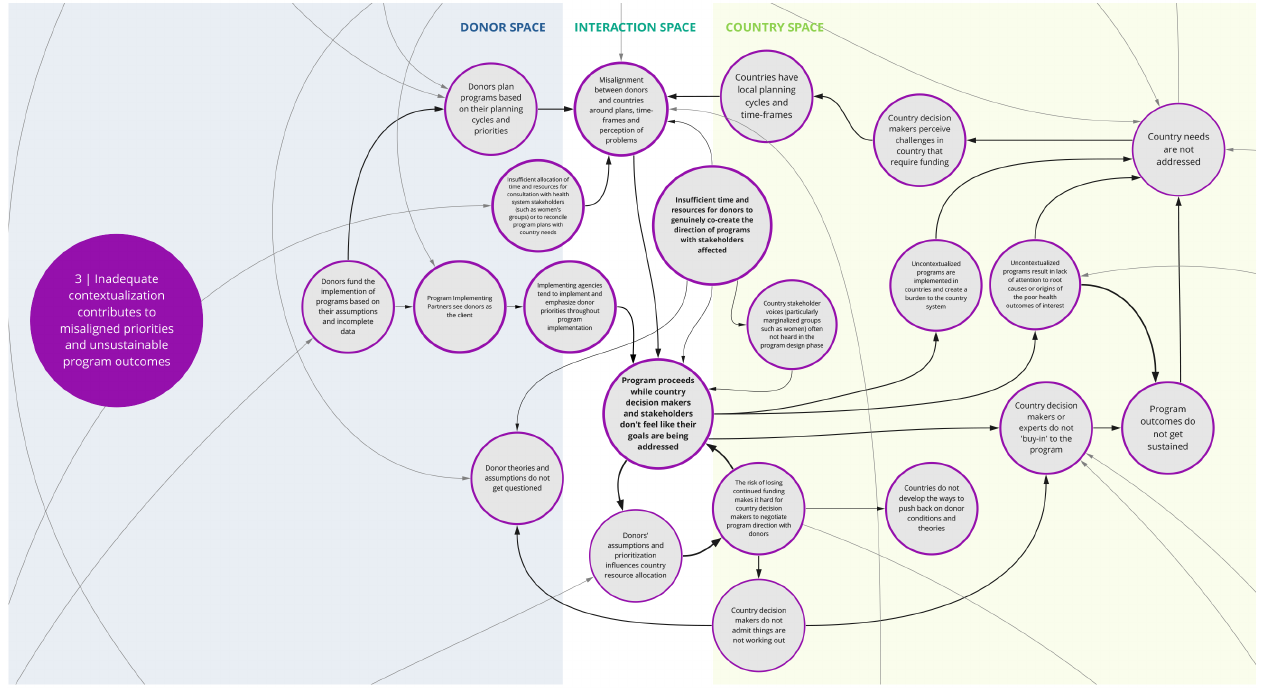
Figure 4. Syndrome 3: Inadequate contextualization contributes to misaligned priorities and unsustainable program